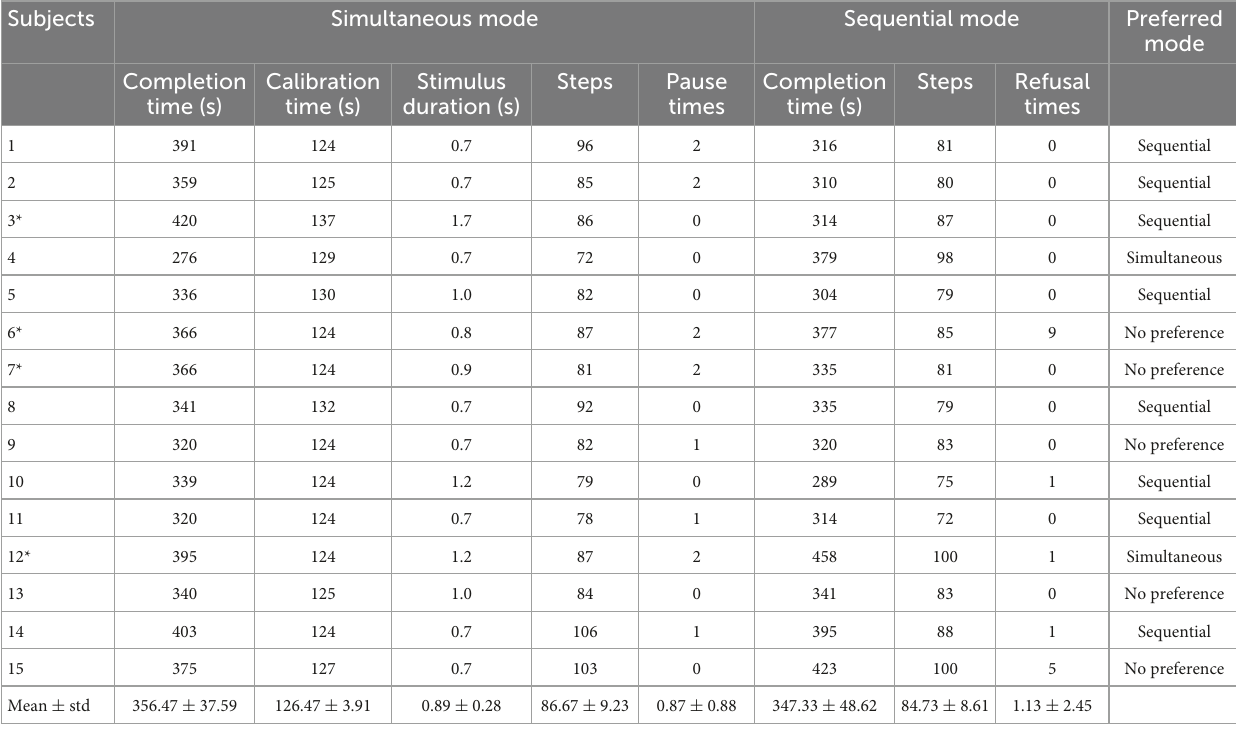
TABLE 1 Performance comparison of each subject between two modes in online